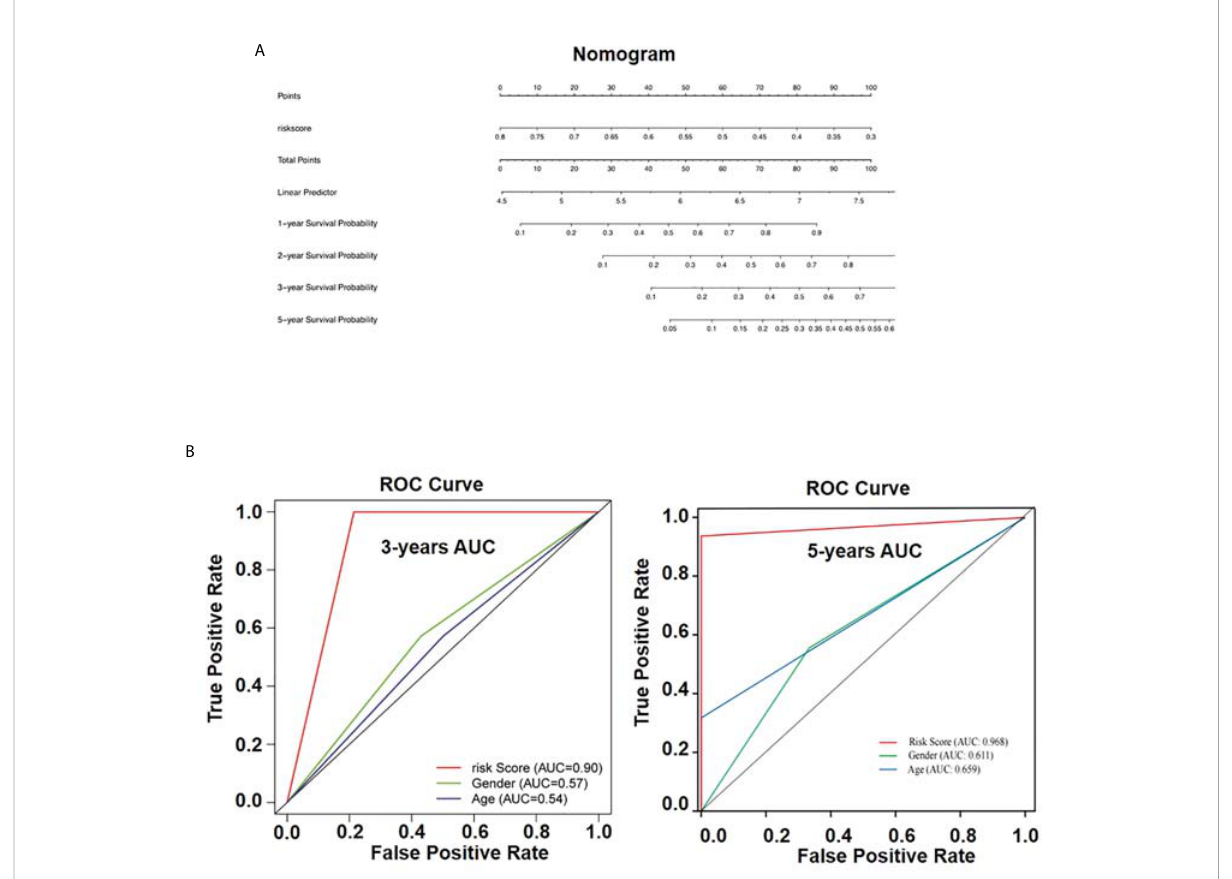
FIGURE 8 Nomogram for overall survival prediction in osteosarcoma patients. (A) The nomogram consists of risk score based on the AIM2/PKIB expression pro fi le. (B) The ROC curves of the risk subgroups by the tertiles of total points derived from the